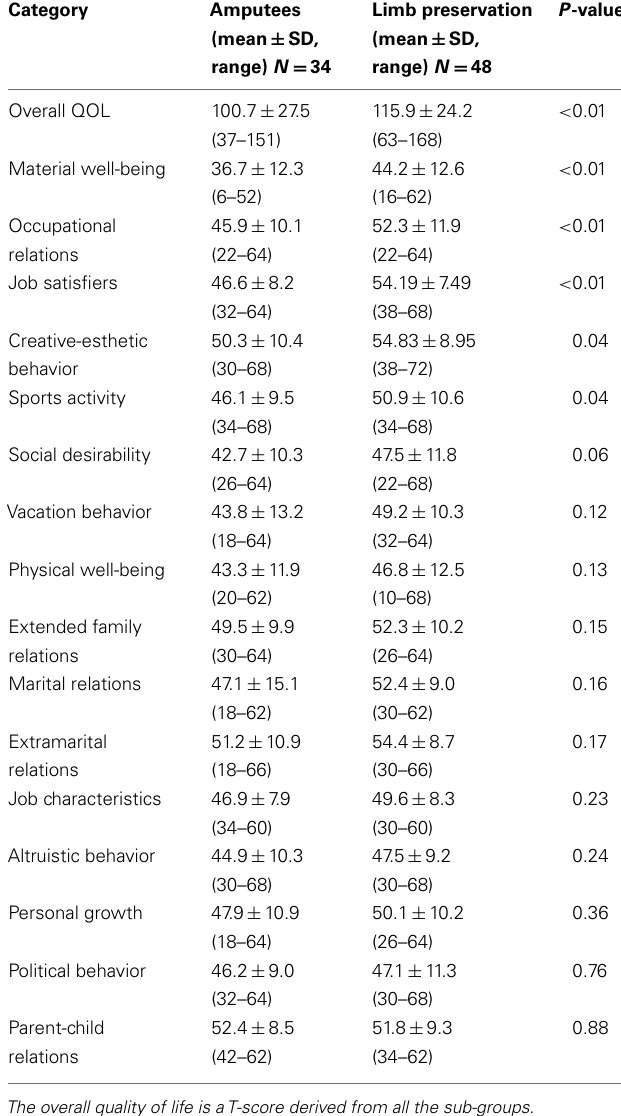
Table 2 | Comparison of the quality of life questionnaire of patients with amputation and limb